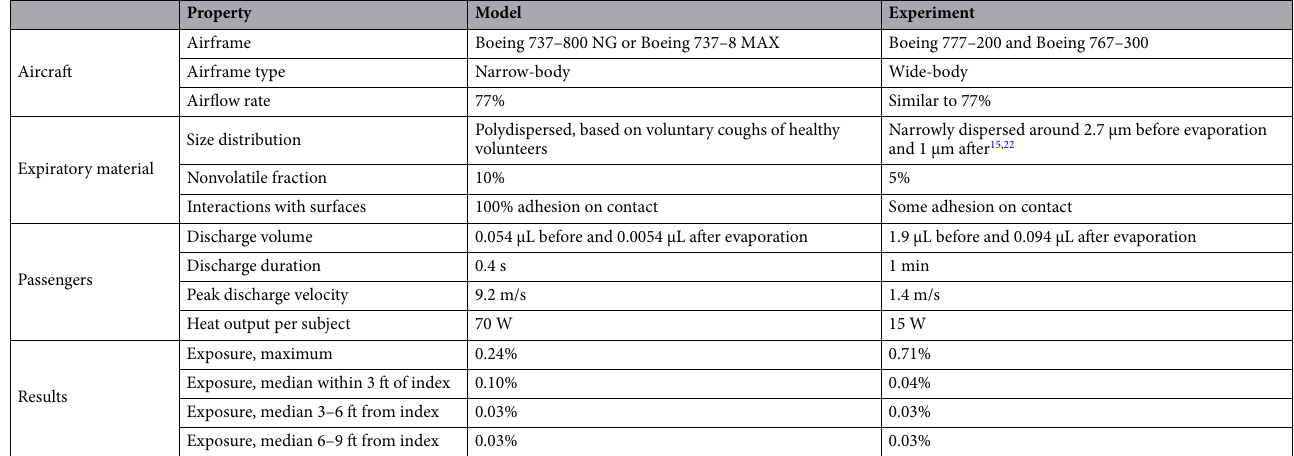
Table 1. Comparison of methods and results used to characterize particle exposure in the computational model and in experimental testing performed by the TRANSCOM/AMC